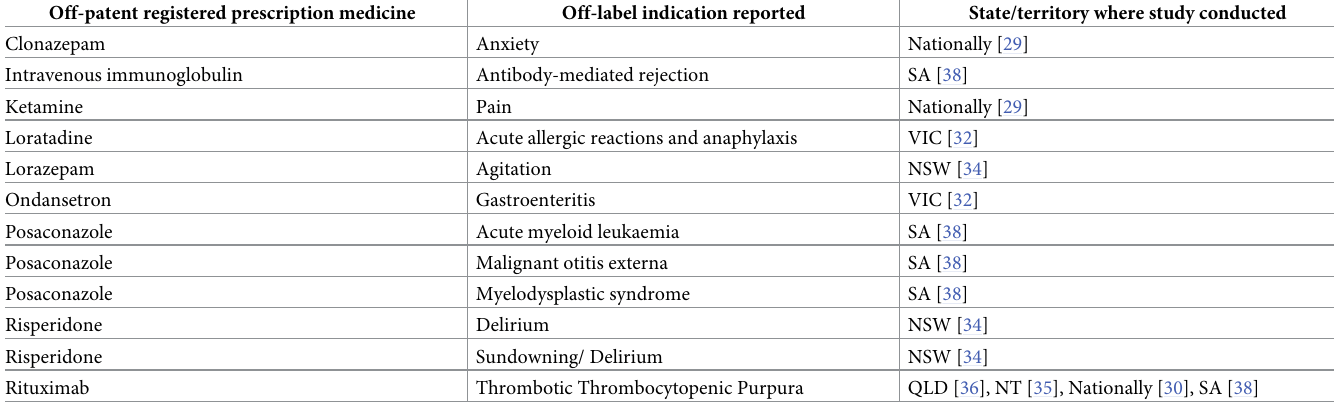
Table 6. Medication/off-label indication dyads only found on QLD LAM and in the literature.